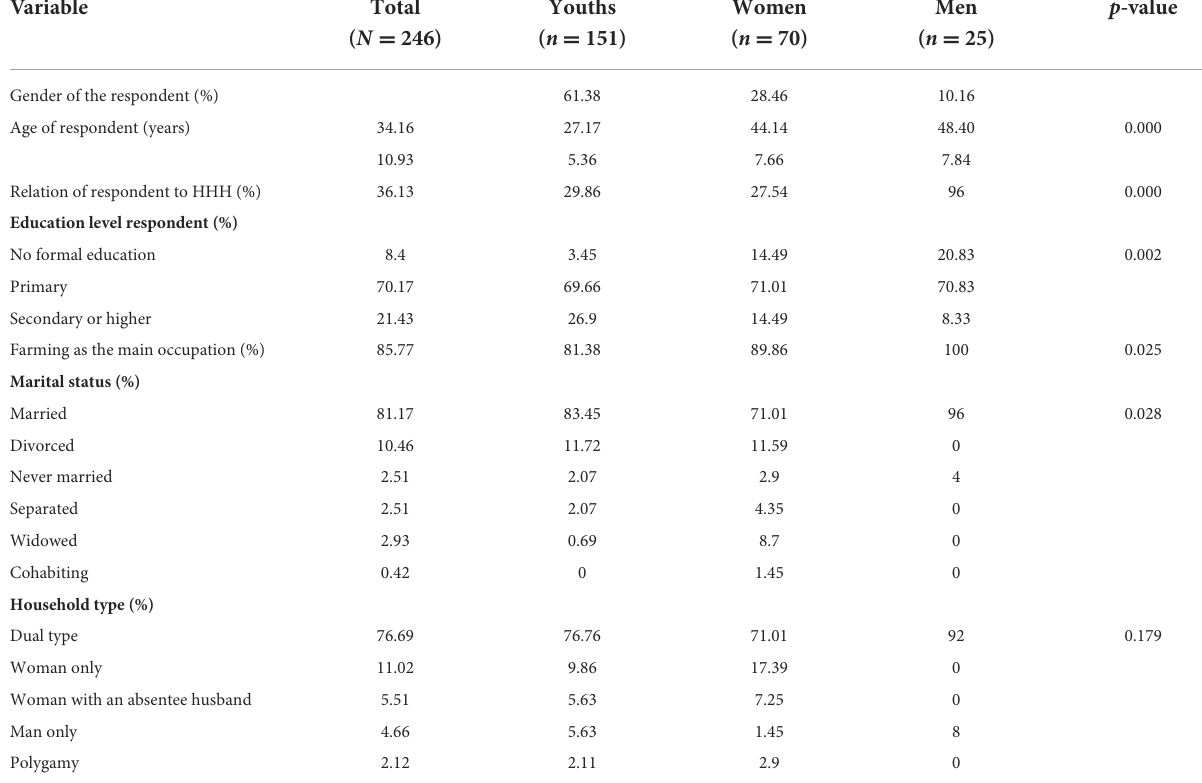
TABLE 1 Socio-demographic characteristics of respondents by gender.